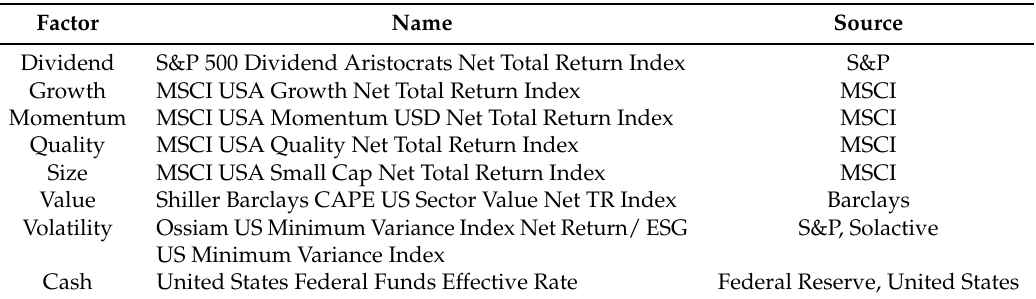
Table 11. Factor-based strategies and cash. For the volatility factor, we chained two strategies on 18 December 2009. Data in USD.